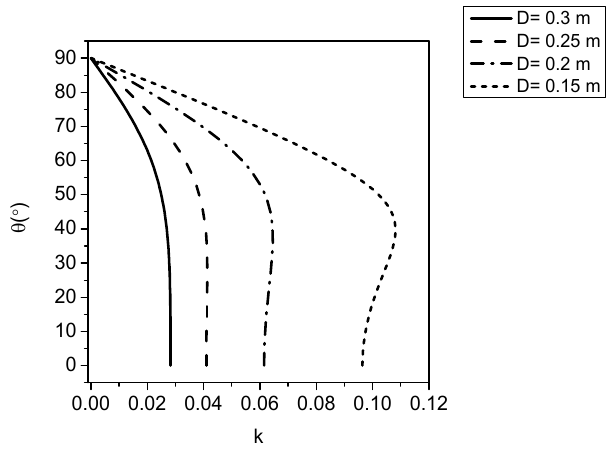
Figure 11. Angle, θ , vs. coupling coefficient, k , at different distances, D , without lateral misalignments of the two coils in Figure 3.